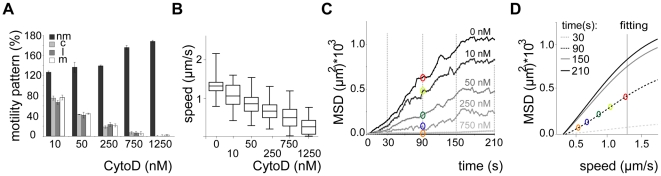
Dispersal of sporozoites under the influence of an actin filament-disrupting drug.(A, B) Automated detection of sporozoite movement patterns normalized to the control (0 nM cytoD = 100%) (A) and median speed distribution in a whiskers plot (B) from parasites imaged in the presence of increasing concentrations of cytochalasin D in 3 µm arrays. More than 150 sporozoites were tracked for each drug condition. Motility patterns: nm = non motile; c = circling; l = linear; m = meandering. (C) MSD over time for motile sporozoites imaged after adding increasing concentrations of cytochalasin D as indicated. Grey lines and colored circles indicate the distinct time points and the respective MSD values, respectively, as plotted in (D). (D) Fitted data of MSD at distinct time points from (C) versus the average speed of the sporozoite population under the varying concentrations of cytochalasin D from (B). Colored circles correspond to the MSD values extracted at 90 s as an example (C).